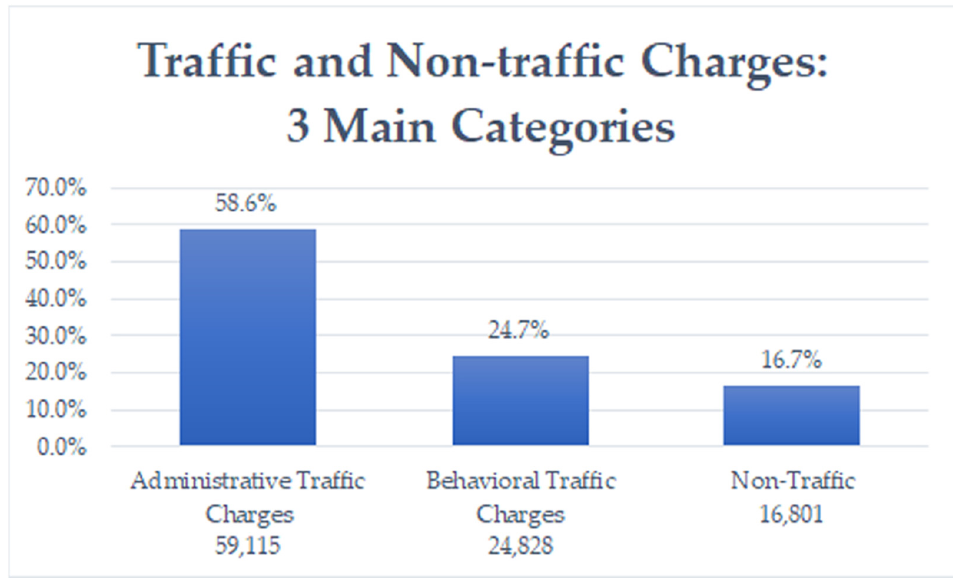
Figure 2. Traffic and Non-traffic Charges: 3 Main Categories.